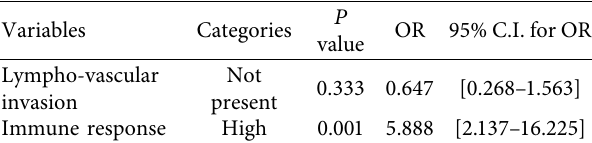
Table 7: Logistic regression analysis of factors associated with survival in patients with colorectal cancer at